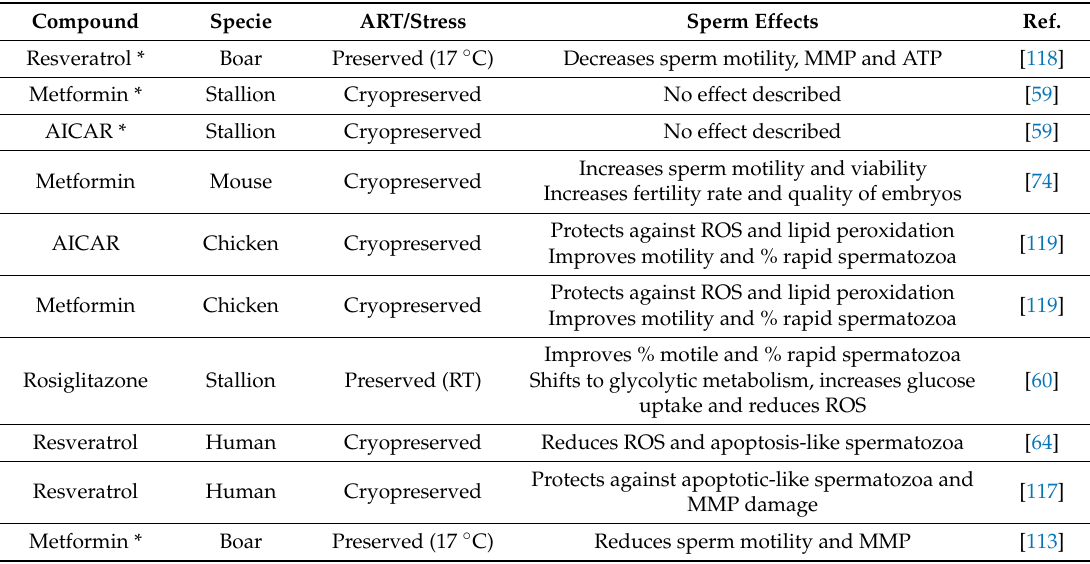
Table 2. Demonstrated effects of direct (AICAR) or indirect AMPK activators (resveratrol, metformin and rosiglitazone) in the spermatozoa functions of different species during Assisted Reproduction Techniques (ART). Cryopreservation was always at − 196 ◦ C. * It has not been showed that the indicated compound effectively activates AMPK in spermatozoa from the indicated